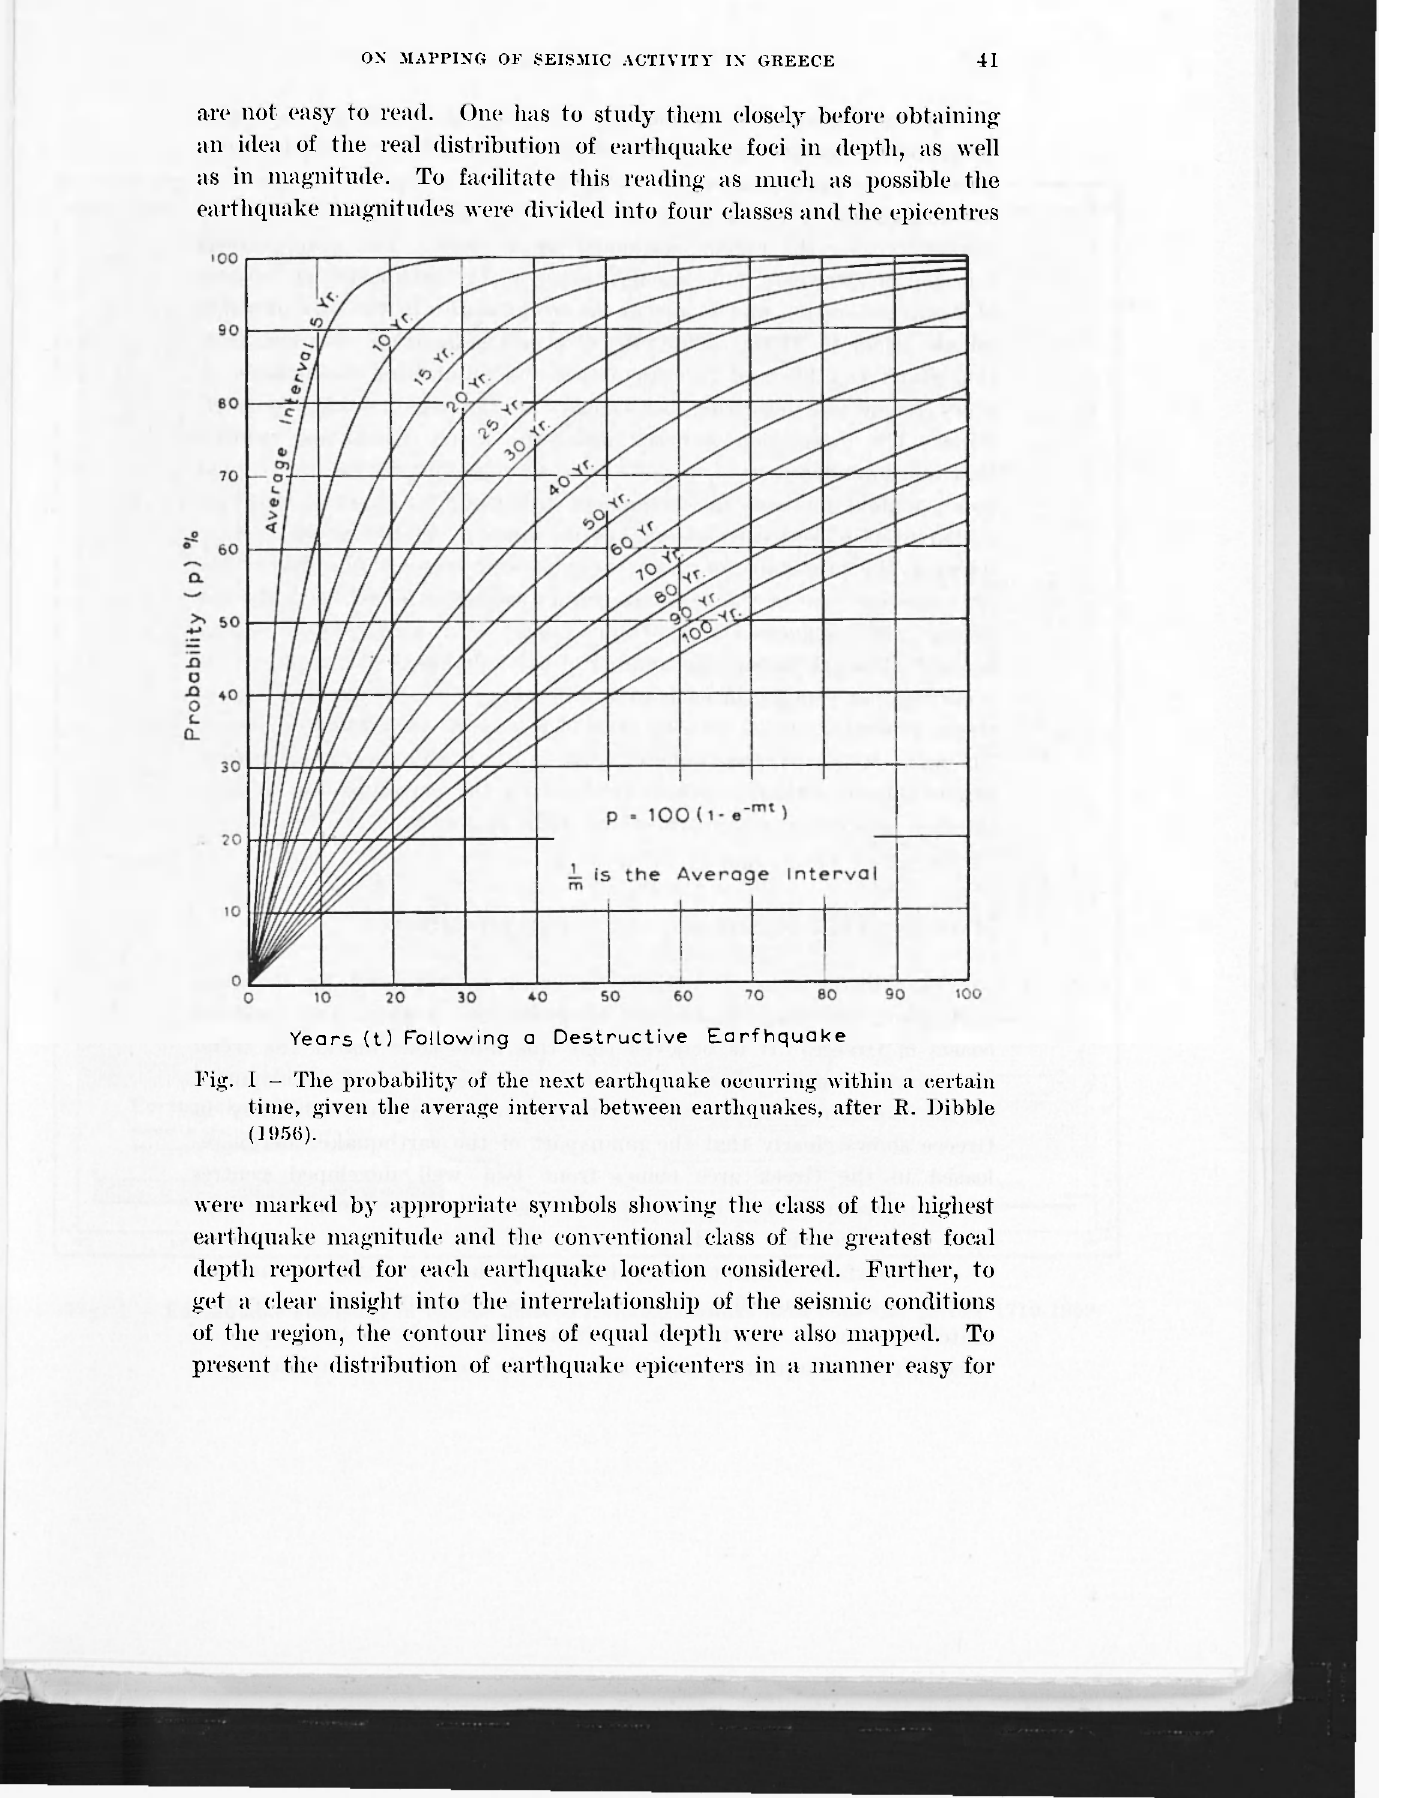
Fig. I - Tlie probability of the next earthquake occurring within a certain time, given tlie average interval between earthquakes, after R. Dibble (1956). were marked by appropriate symbols showing the class of the highest earthquake magnitude and the conventional class of the greatest focal depth reported for eacli earthquake location